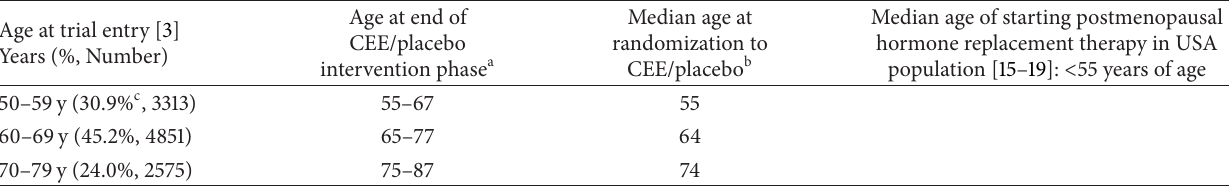
Table 1: Women’s Health Initiative Estrogen-Alone Trial, age of participants in estrogen/placebo (intervention) phase of trial. Age at trial entry